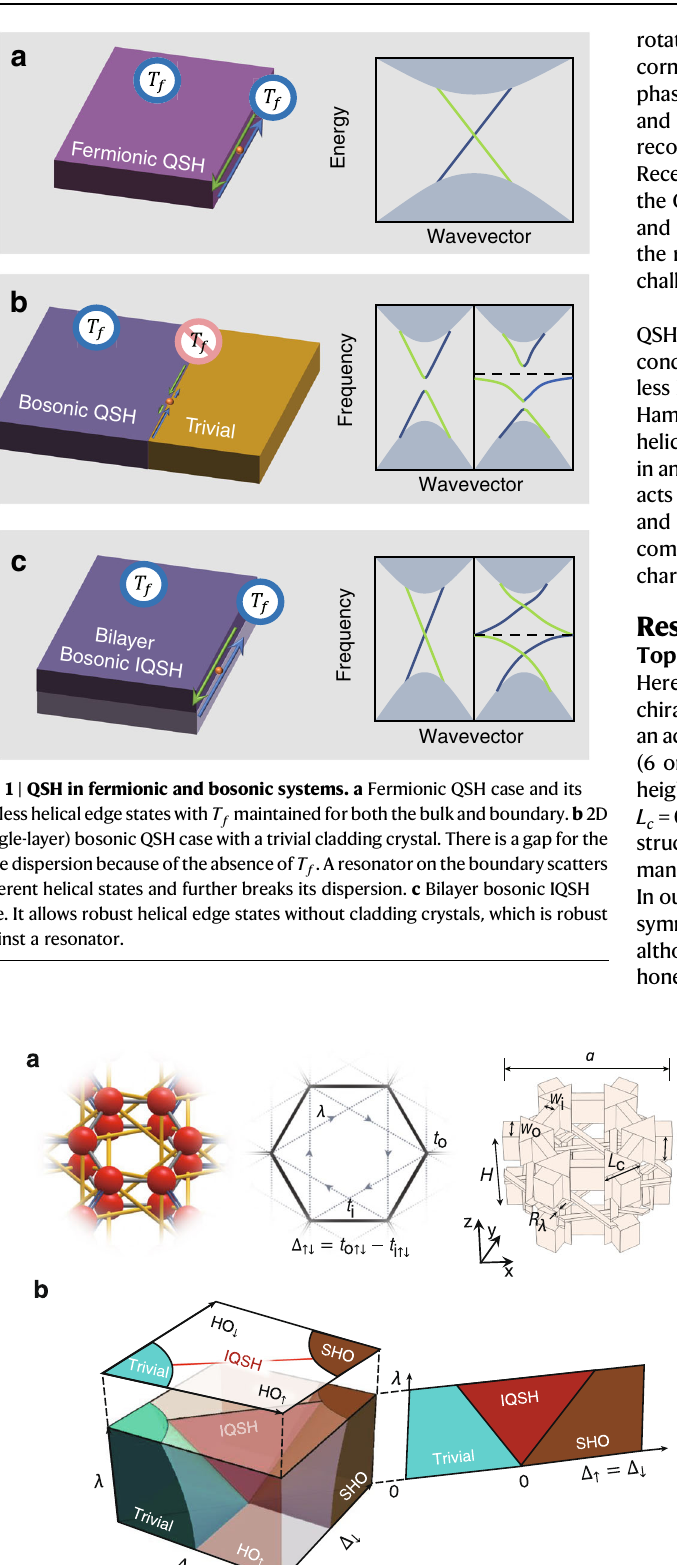
hopping difference where the subscript arrow denotes the upper or lower layer. c Phasetransitionprocessrelyingoneitherbulkoredgebandinversion,where p 1,2 and d 1,2 represent degenerate dipole and quadrupole modes,